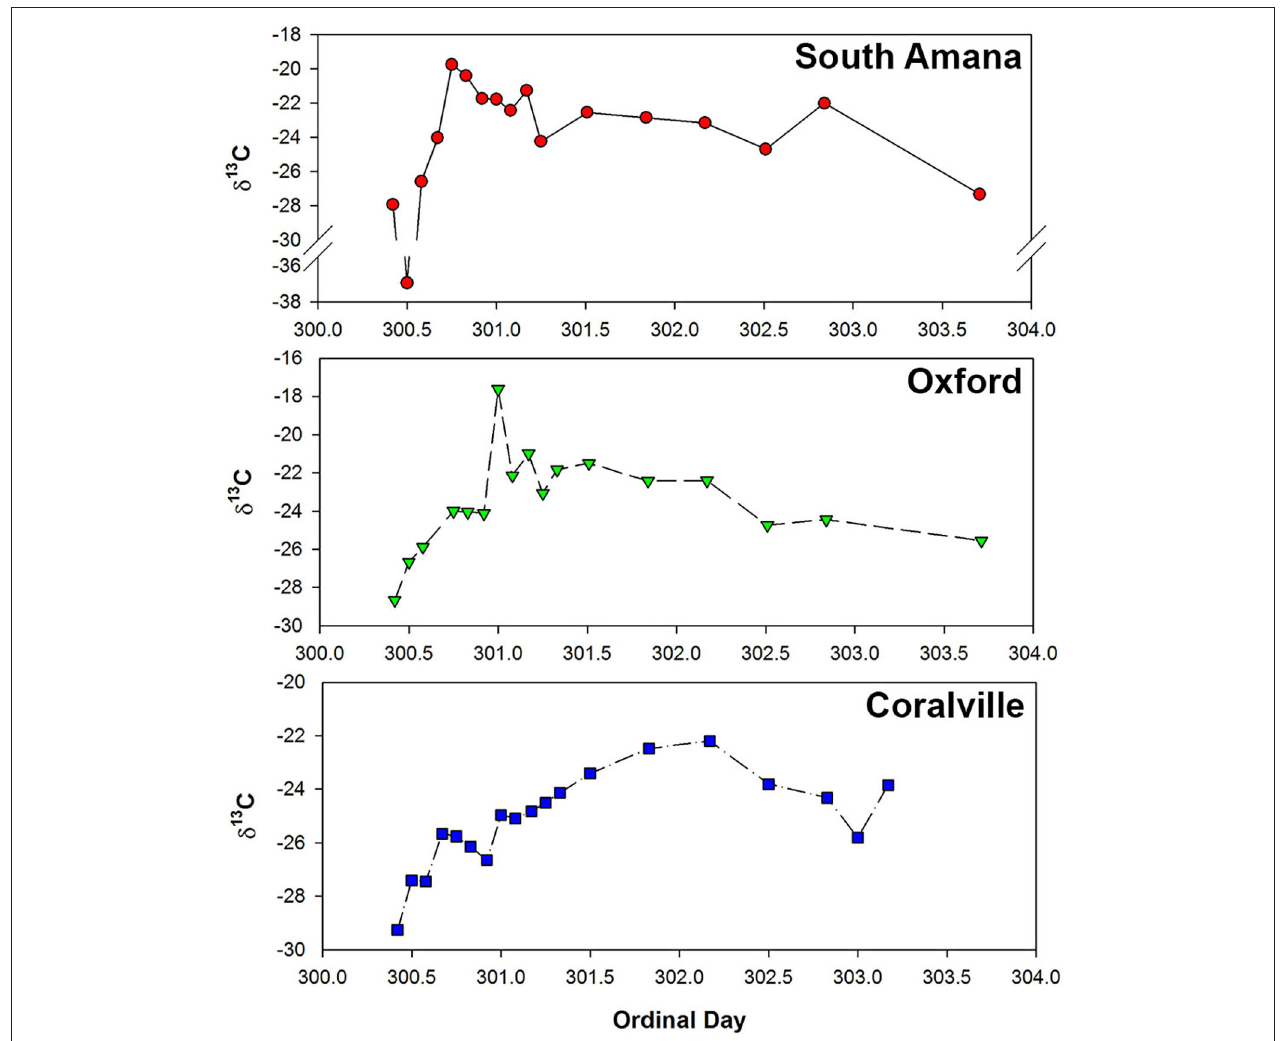
FIGURE 3 | Temporal variations in δ 13 C of POC samples during the October, 2015 storm. From the upper panel on down, South Amana, Oxford, and